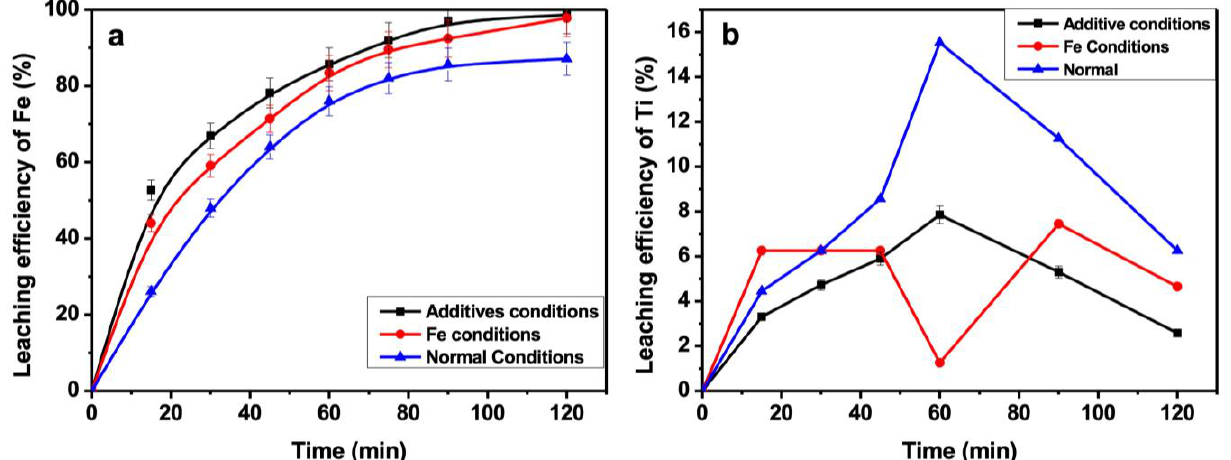
Figure 10. The influence of retention time on the ( a ) Fe and ( b ) Ti dissolution under HCl condition (normal), Fe-HCl (iron condition), and Fe-MgSO 4 -HCl (additives condition). Conditions: particle size, +150 µm; acid concentration, 7.5 M; solid – liquid ratio, 1:20; agitation speed, 450 rpm; temperature, 90 °C; agitation time, 120 min.